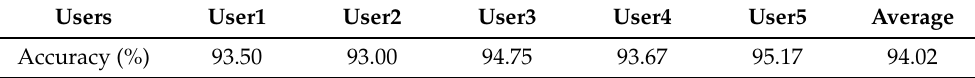
Table 10. The DCN-TL recognition accuracy for different